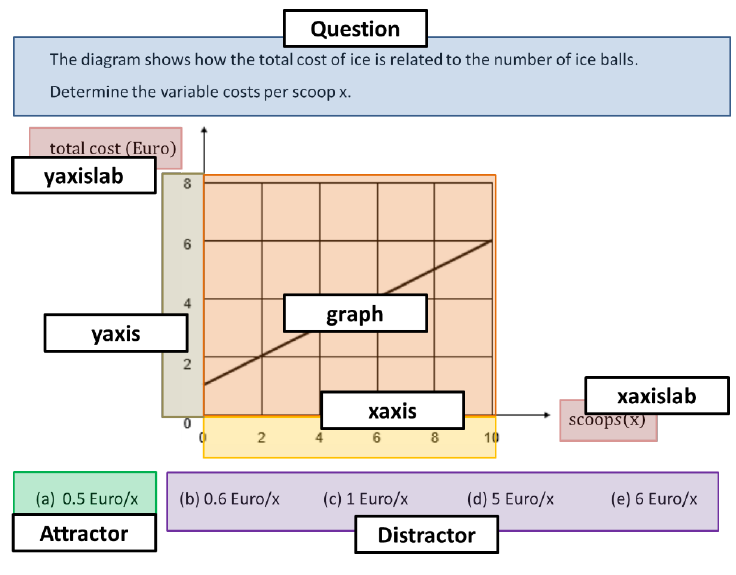
Figure 2. AOIs of a single graph task.